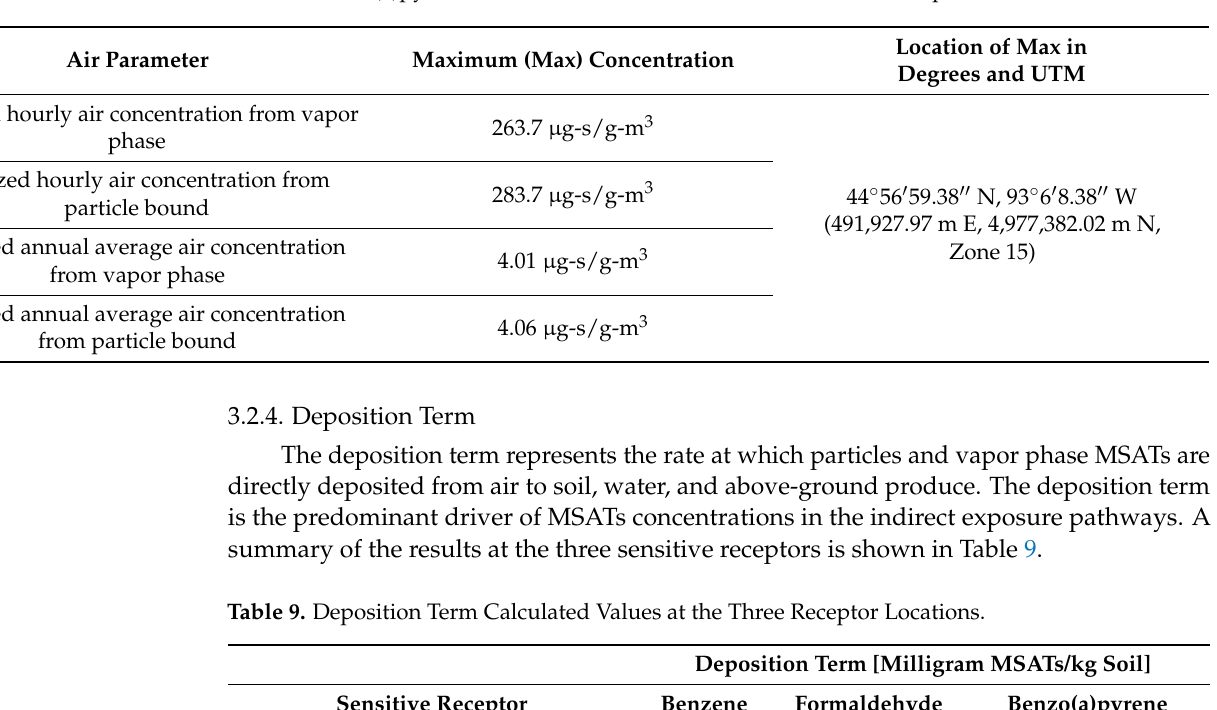
Table 8. Benzo(a)pyrene Maximum Concentration Values and their Respective Locations.